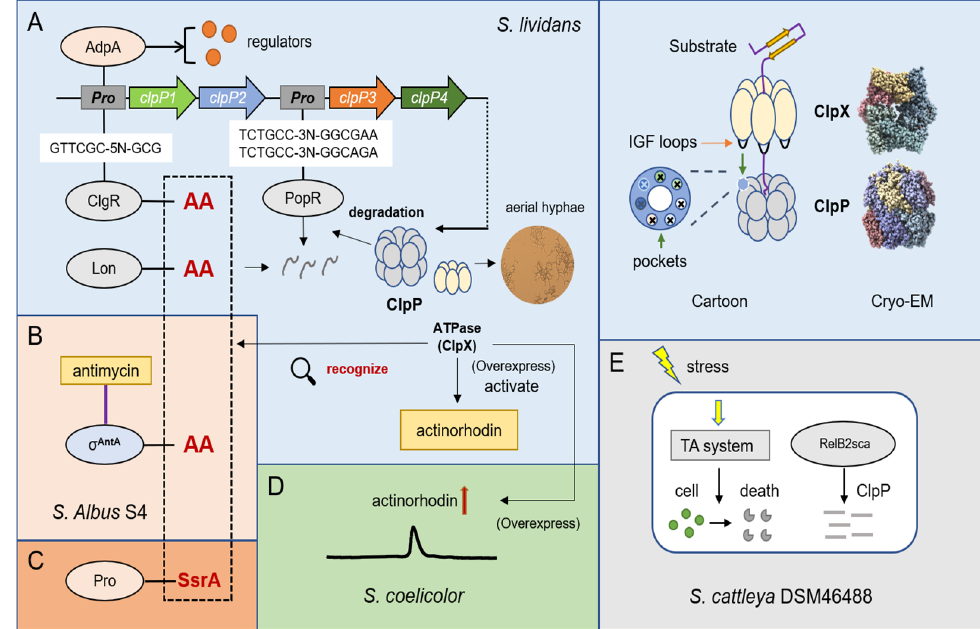
Figure 2. Overview of the degradation mechanism of ClpP protease and its regulation on metabolism. ( A ) Cryo—EM structures and cartoon structures of ClpP protease and ClpX (Cryo—EM structures of E . coli were downloaded from PDB database). ClpP protease can degrade important regulators ClgR, Lon, and PopR in S. lividans . ( B ) Two alanines in the C-terminal of σ AntA are essential for degradation by ClpP in S. albus S4. ( C ) ClpXP can specifically degrade SsrA-tagged proteins. ( D ) Overexpression of clpX can increase the production of actinorhodin in S. coelicolor . ( E ) The type II toxin—antitoxin (TA) system is regulated by ClpP protease in S. cattleya DSM46488 under osmotic pressure.